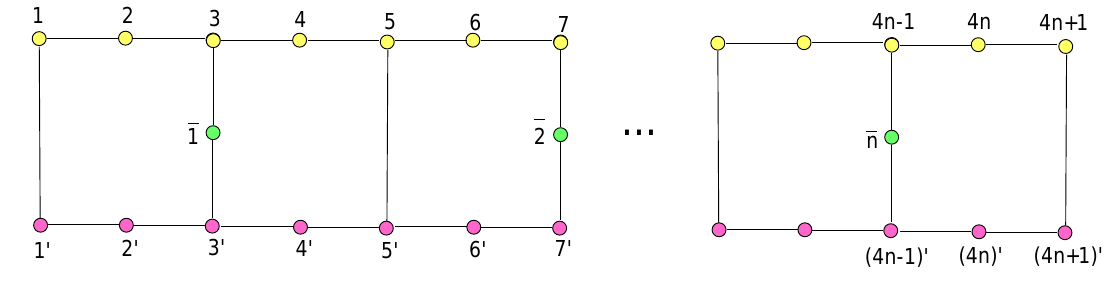
Figure 1. Linear Heptagonal